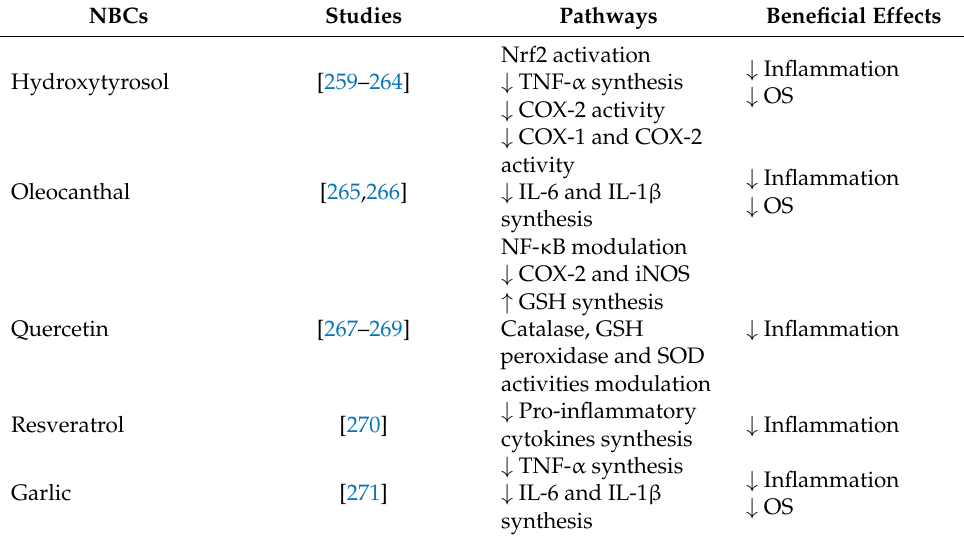
Table 6. NBCs in inflammation and oxidative stress